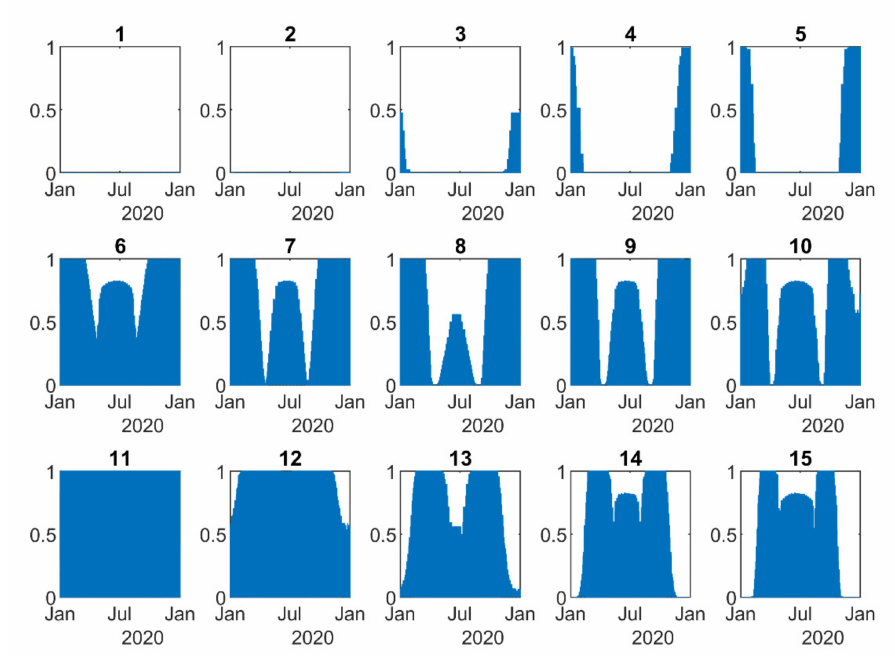
Figure 26. Direct shading factor f B as a function of time for all the modules in the array.